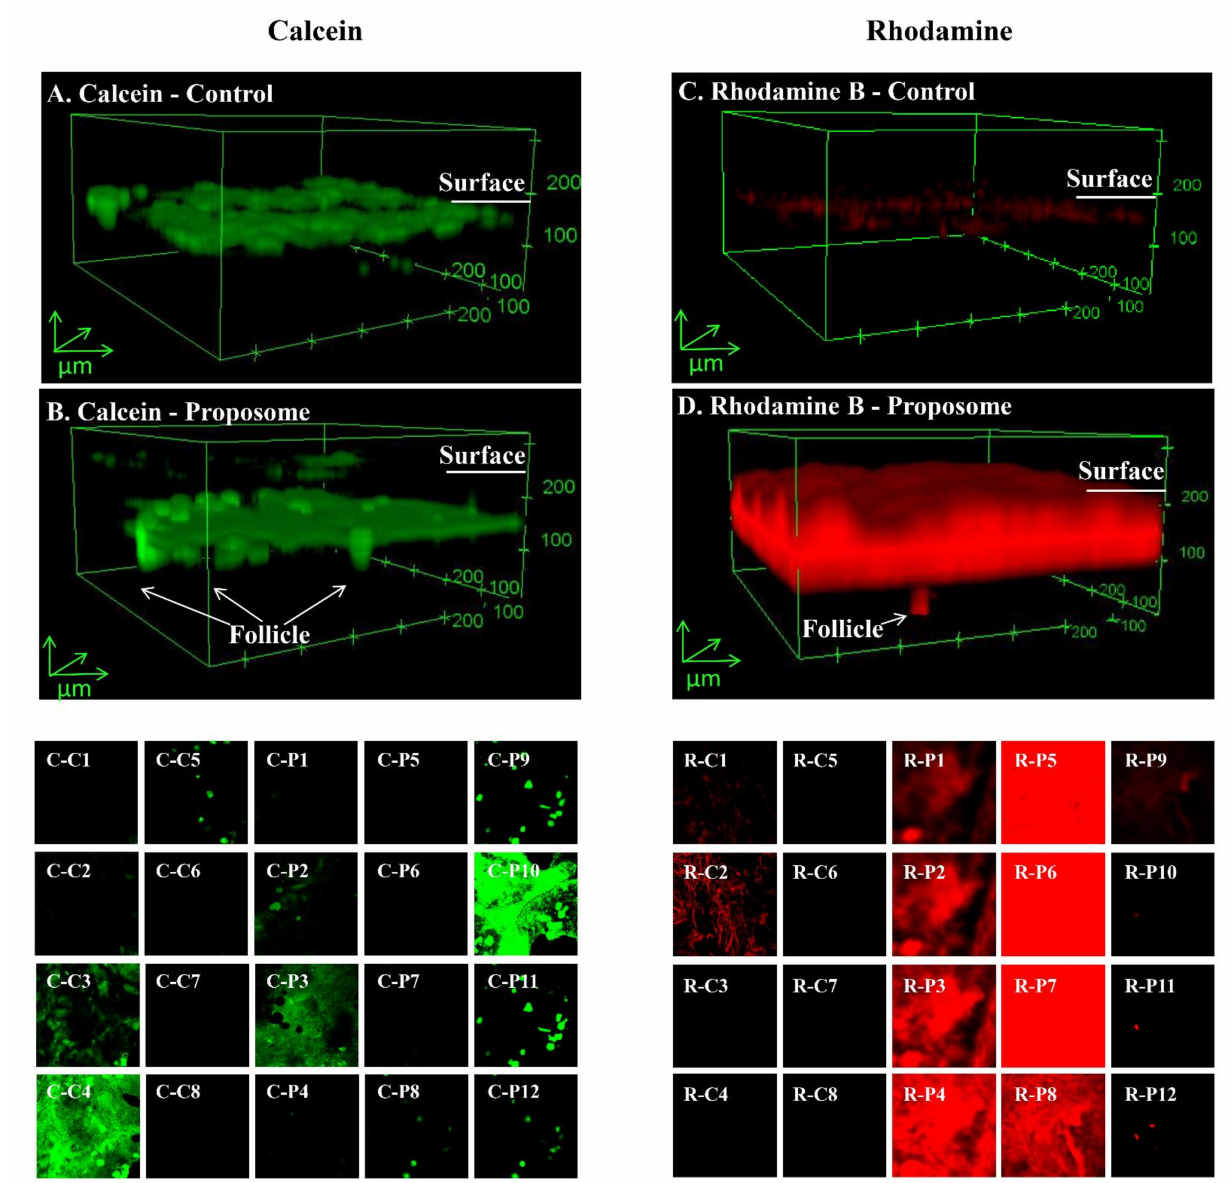
Figure 6. The confocal microscopic images showing fluorescent calcein control ( A ) /proposome ( B ) and rhodamine B ( C ) /proposome ( D ) penetration into human skin after 24 h treatment. Sliced images of calcein control (C-C1 to C8)/proposomes (C-P1 to P12, and of rhodamine B control (R-C1 to C8) and proposome (R-P1 to P12). Each slice is 20 µ m. The control was 0.2% w / v calcein or rhodamine B solution in 30% PG. The concentrations of calcein and rhodamine B were same for proposomes and